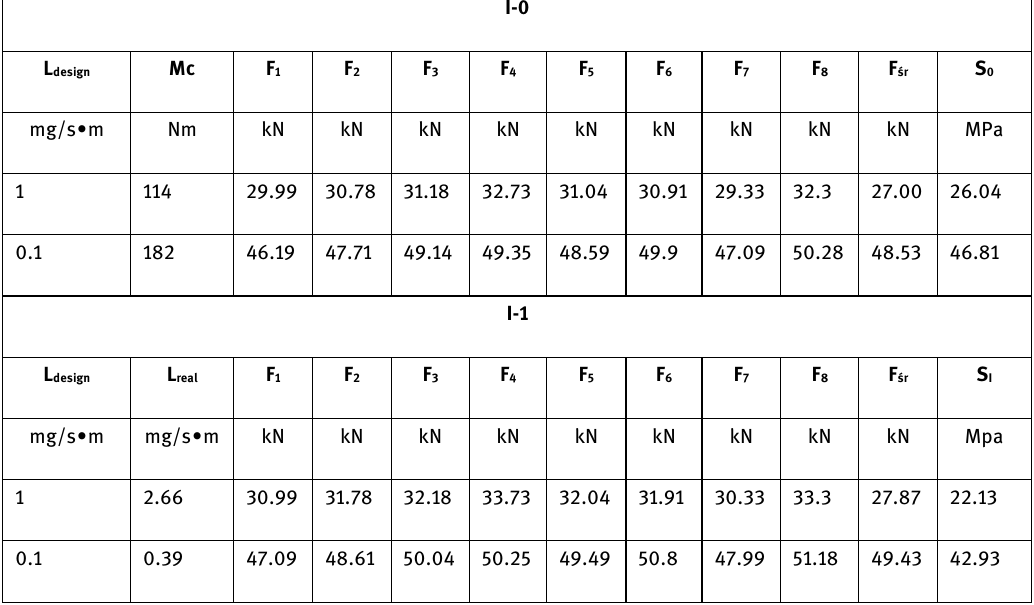
Table 7: Listing of measurement and target data in the form of tightening torque of nuts, tightness class and bolt forces for joint gasketed FG_2 material.